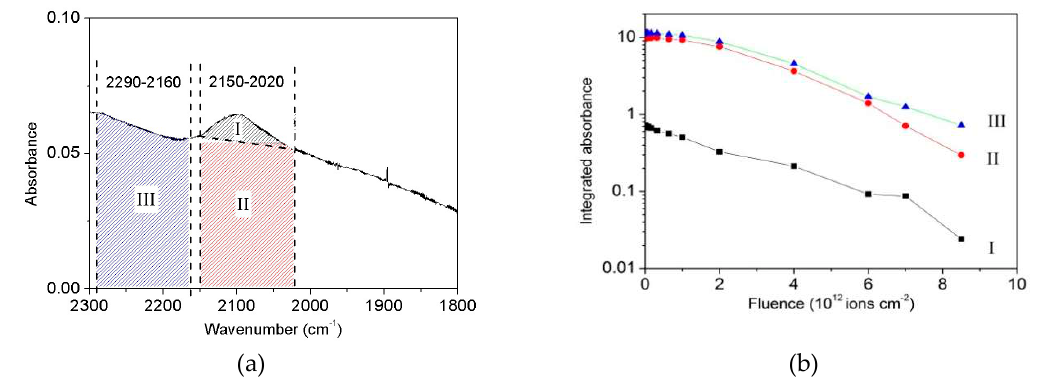
Figure 7. ( a ) Valine IR spectrum around the 2109 cm − 1 band. The three regions selected correspond to: (I) the 2109 cm − 1 band, (II) background below this band, and (III) background next to it. ( b ) The integrated absorbance evolution with projectile fluence for these three spectrum regions.